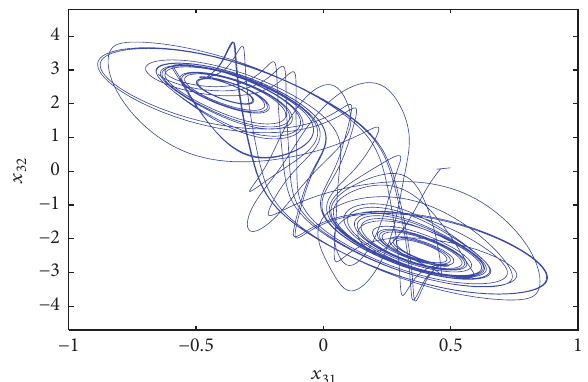
Figure 6: The chaotic behavior of each node in the second cluster in (66).